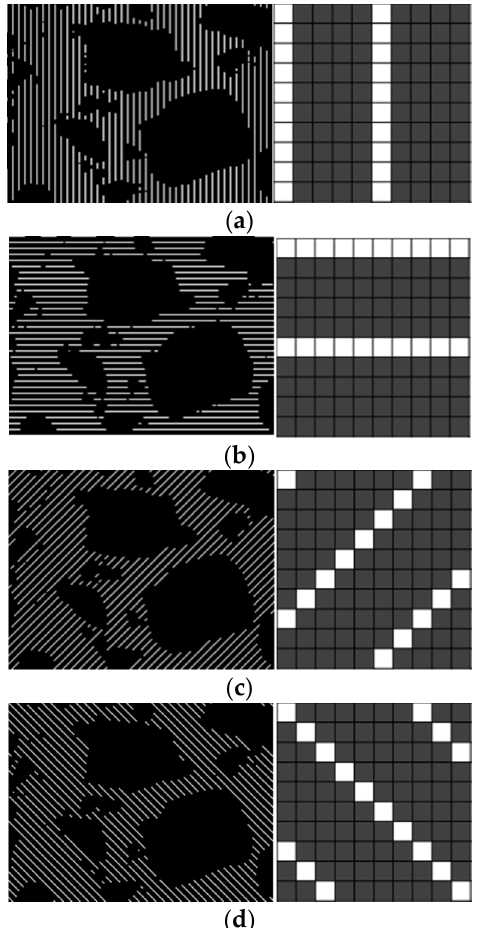
Figure 4. Sampling masks in the directions of ( a ) 90°, ( b ) 0°, ( c ) 45°, and ( d ) 135°.